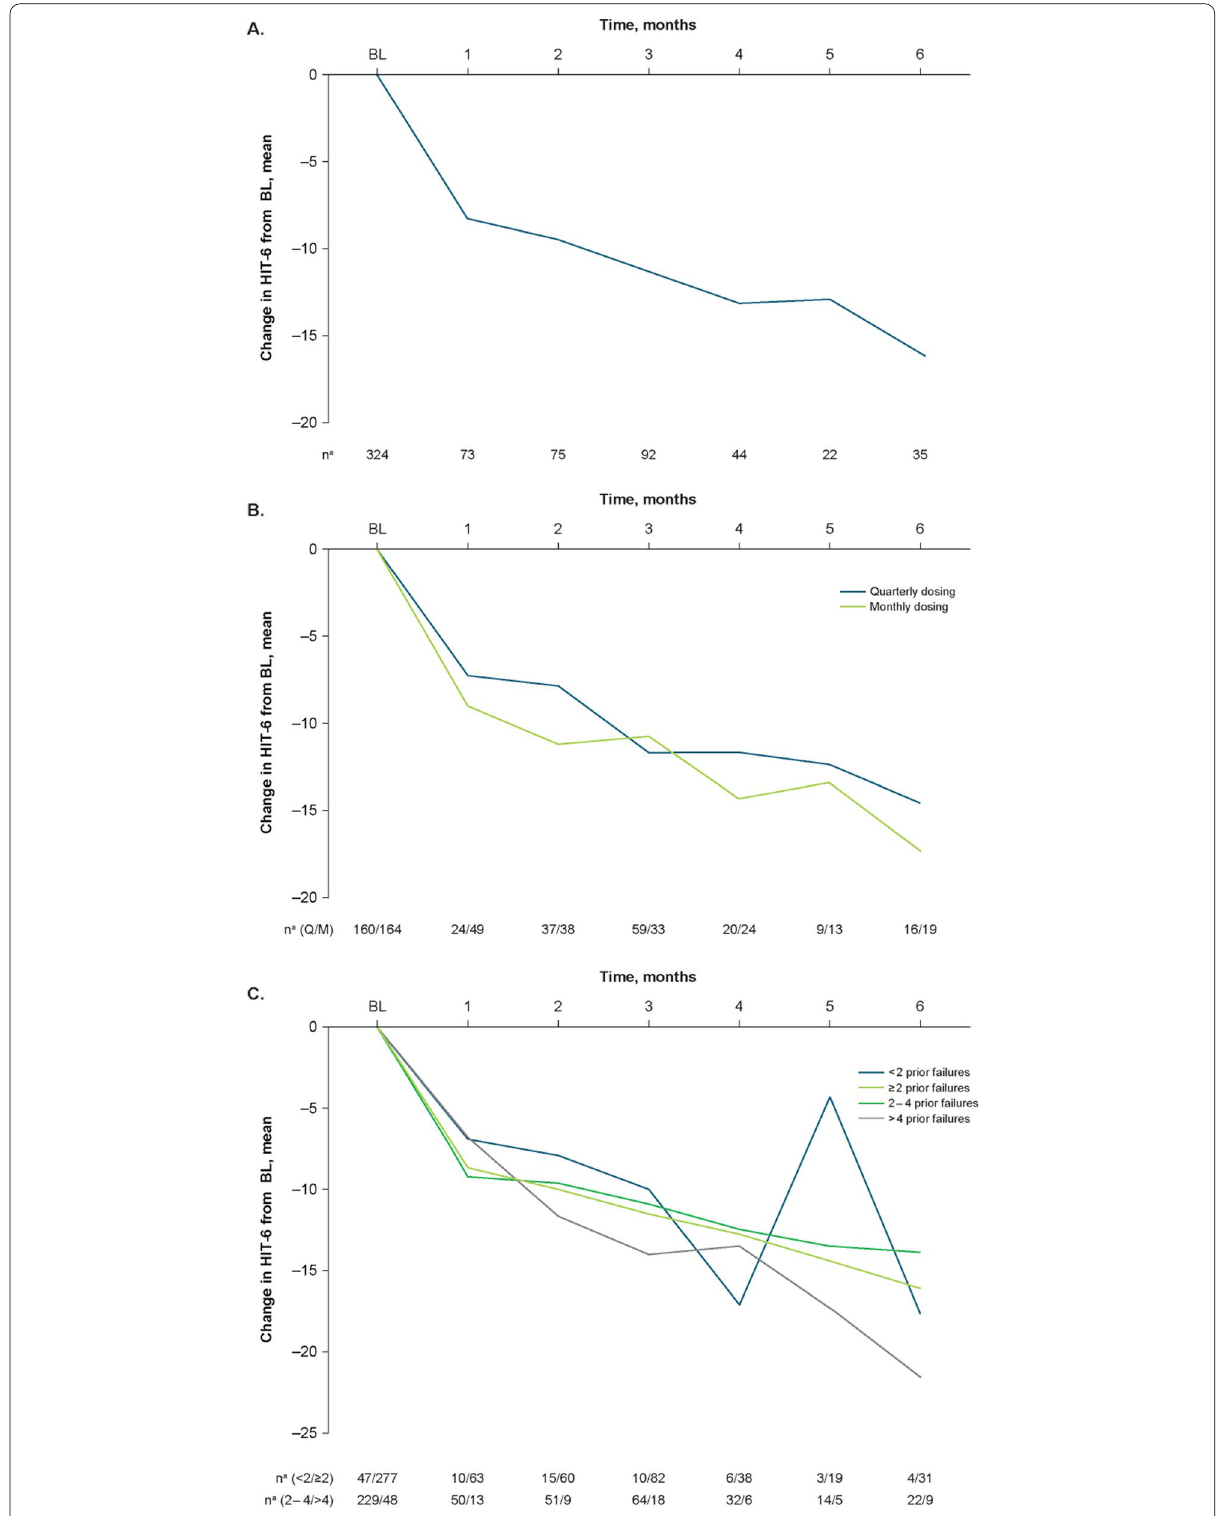
Fig. 5 Effectiveness outcomes by change from baseline in HIT‑6 scores: A ) total population; B ) dosing schedule subgroups; C ) prior treatment failures subgroups. BL, baseline; HIT‑6, 6‑item Headache Impact Test; Q, quarterly; M, monthly. a Number of patients with available assessment at each time